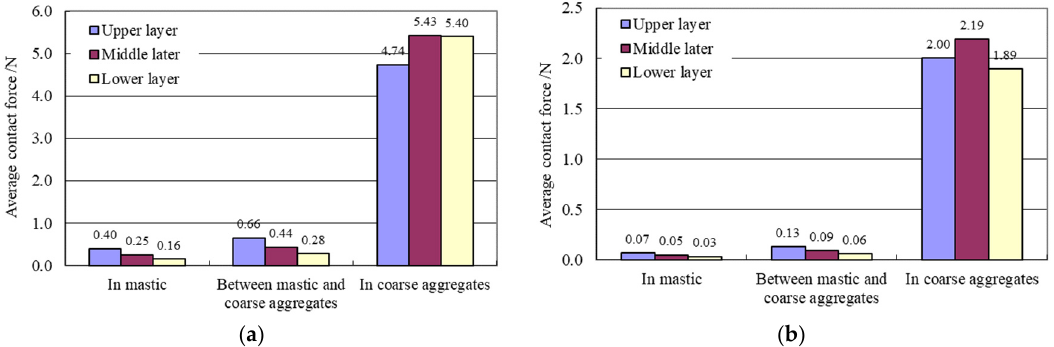
Figure 7. Average of the contact forces in each asphalt layer. ( a ) Normal contact force. ( b ) Tangential contact force.